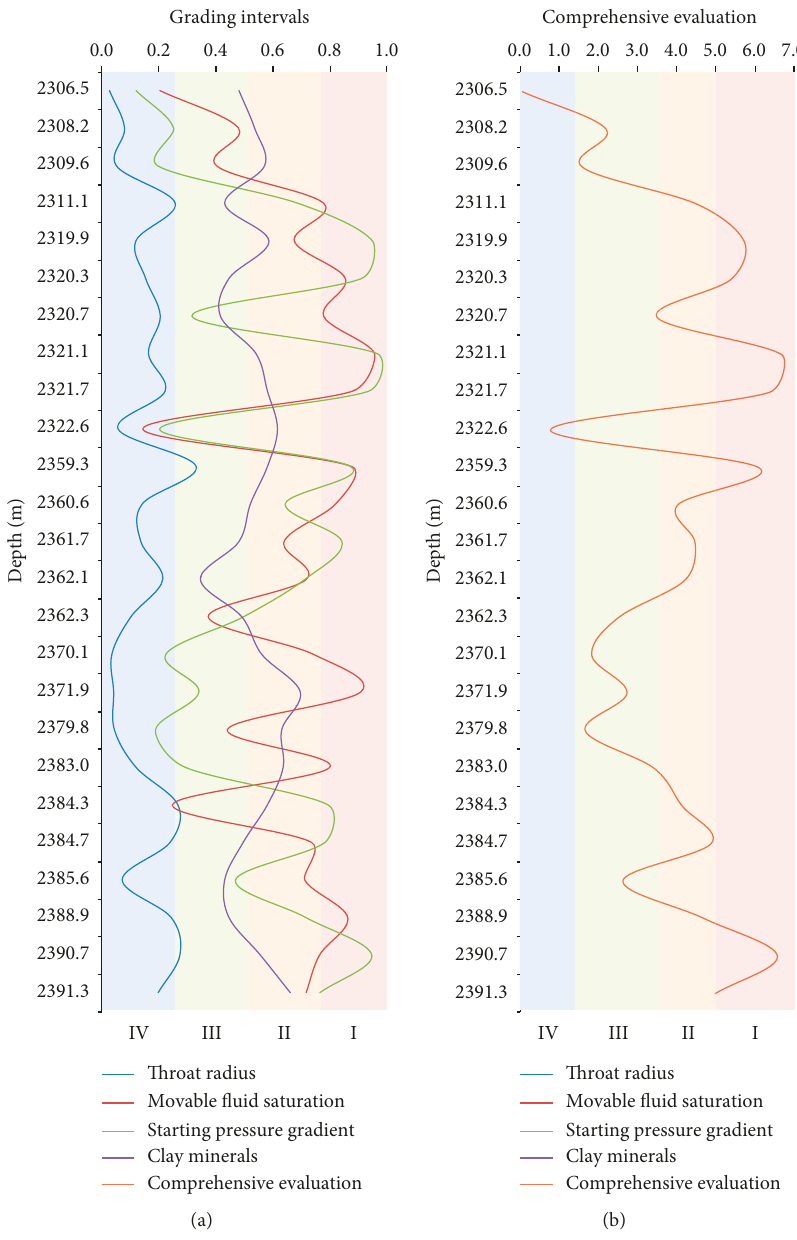
Figure 3: Comprehensive evaluation results and longitudinal grading evaluation results of tight